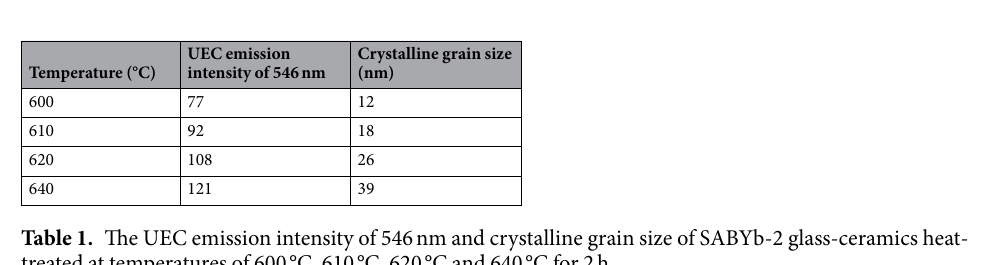
Table 1. The UEC emission intensity of 546 nm and crystalline grain size of SABYb-2 glass-ceramics heat- treated at temperatures of 600 °C, 610 °C, 620 °C and 640 °C for 2